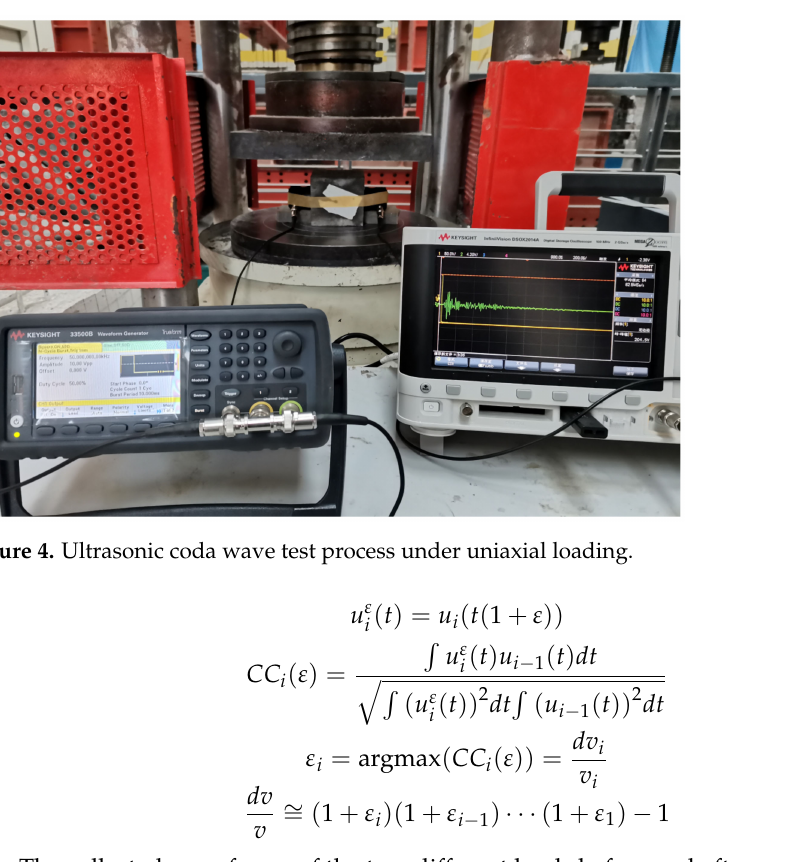
Figure 3. Concrete specimen loading and data collection process.